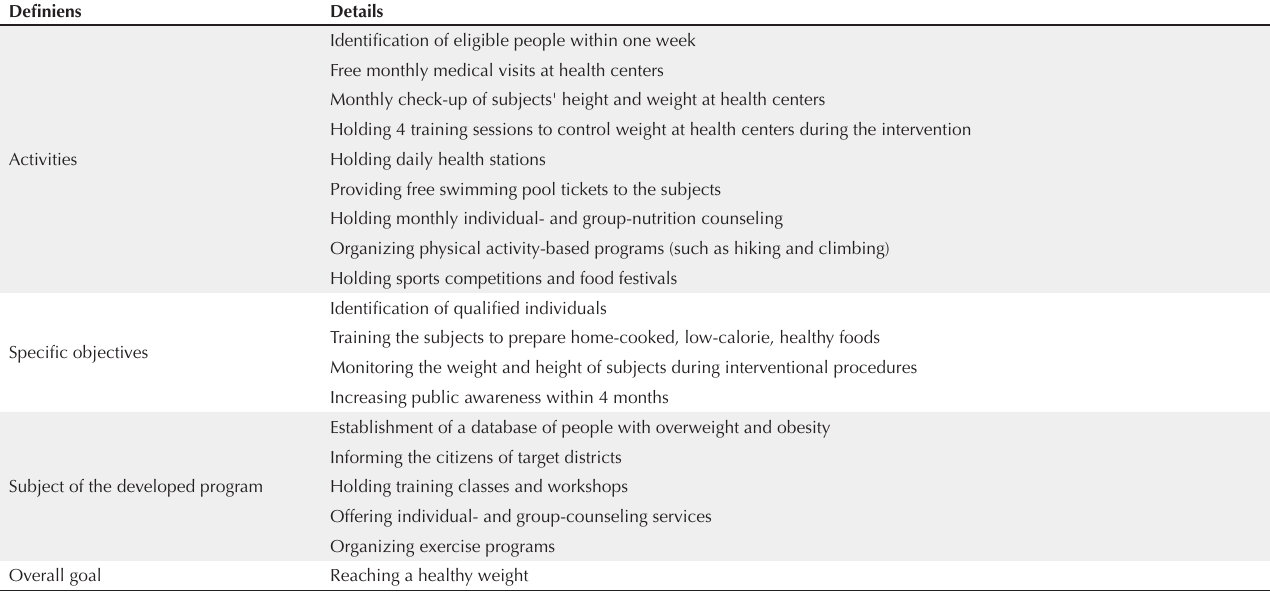
Table 1. Summary of Developed Specific Interventions in the Urban HEART Framework Definiens